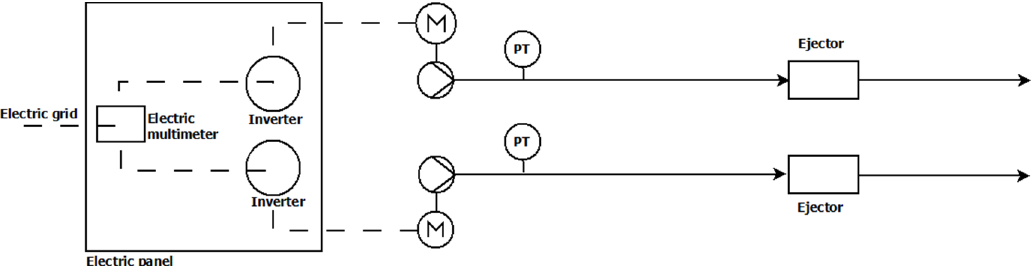
Figure 4. Piping and Instrumentation Diagram (P and ID) of the pilot plant.